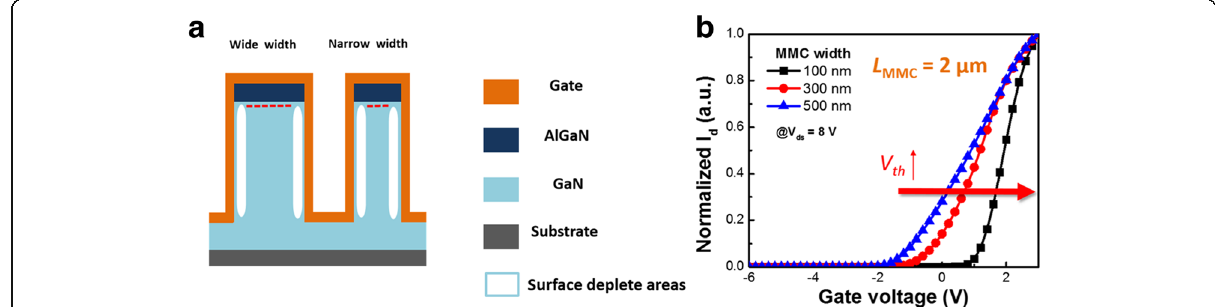
Fig. 3 a Schematic representation of AlGaN/GaN HEMTs having wide and narrow channels. b I DS – V G transfer characteristics measured for a device having a value of L MMC of 2 μ m and various values of W